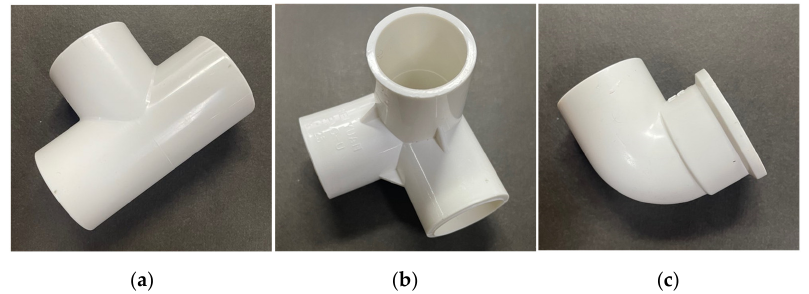
Figure 11. Three kinds of workpieces for experiments. Subfigures ( a – c ) are Tee pipe 1, Tee pipe 2, and Two-way elbow, respectively.